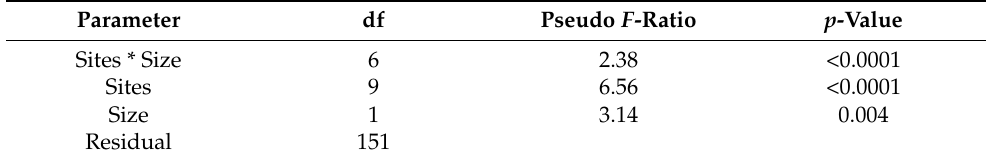
Table 2. Permutational Multivariate Analysis of Variance results in the diet composition of pikeperch Sander lucioperca populations in Portuguese basins.